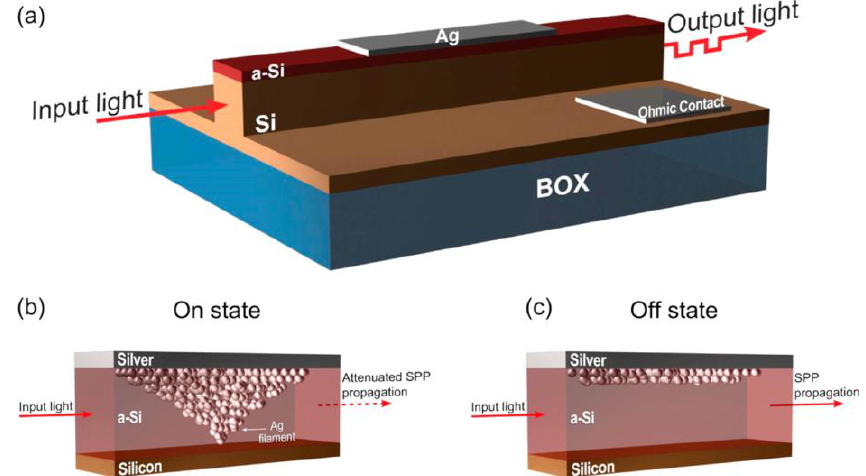
Figure 18. ( a ) Three-dimensional schematic of the investigated optically readable plasmonic RRAM; ( b ) formation of the nanoscale filament in the on state; ( c ) annihilation of the nanoscale filament in the off state (Reprinted with permission from [158].)